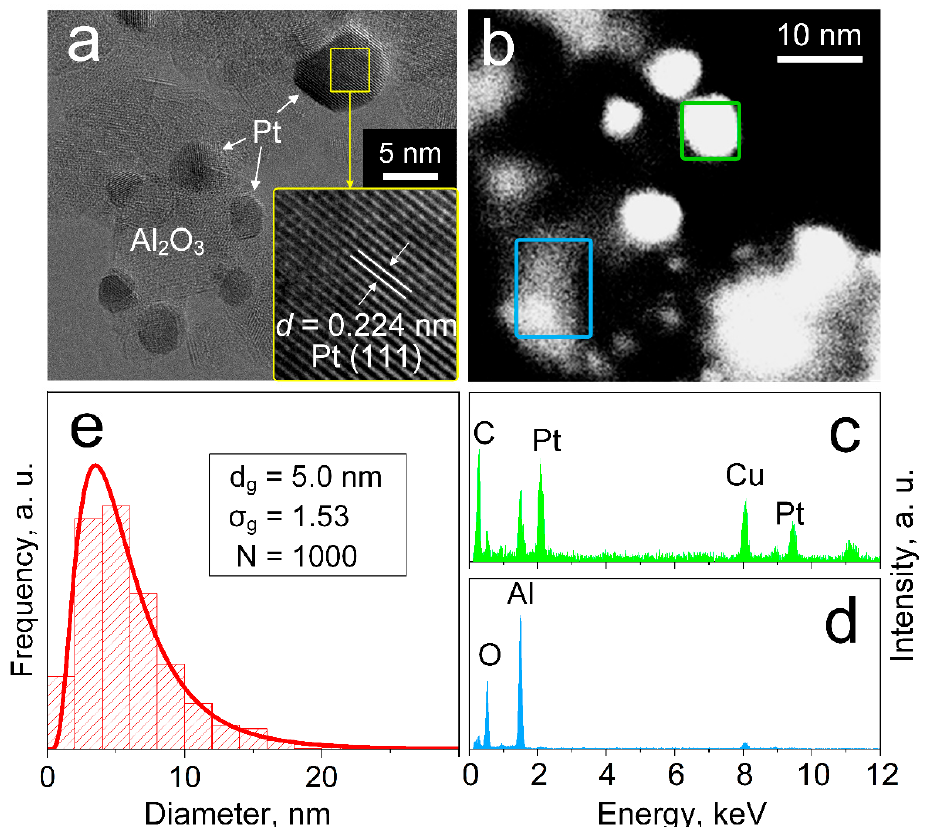
Figure 2. ( a ) HRTEM image of 3 mol% Pt/Al 2 O 3 . The inset shows the lattice fringes corresponding to the Pt (111) crystal plane. ( b ) HAADF-STEM image of such Pt/Al 2 O 3 particles. EDXS analysis of the green ( c ) and blue ( d ) areas in ( b ). ( e ) Particle size distribution as determined from HAADF- STEM, together with the mean geometric diameter (d g ), standard deviation ( σ g ) and number (N) of counted particles.